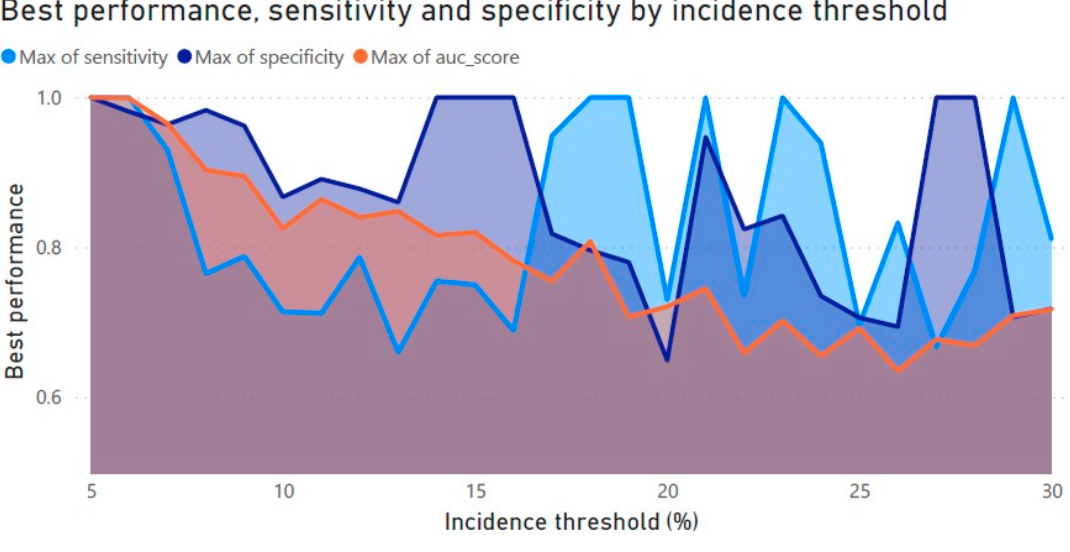
Figure 8. Area chart presenting the best achieved performance (orange), sensitivity (light blue), and specificity (dark blue) among all tested classification algorithms for each tested stress incidence threshold.